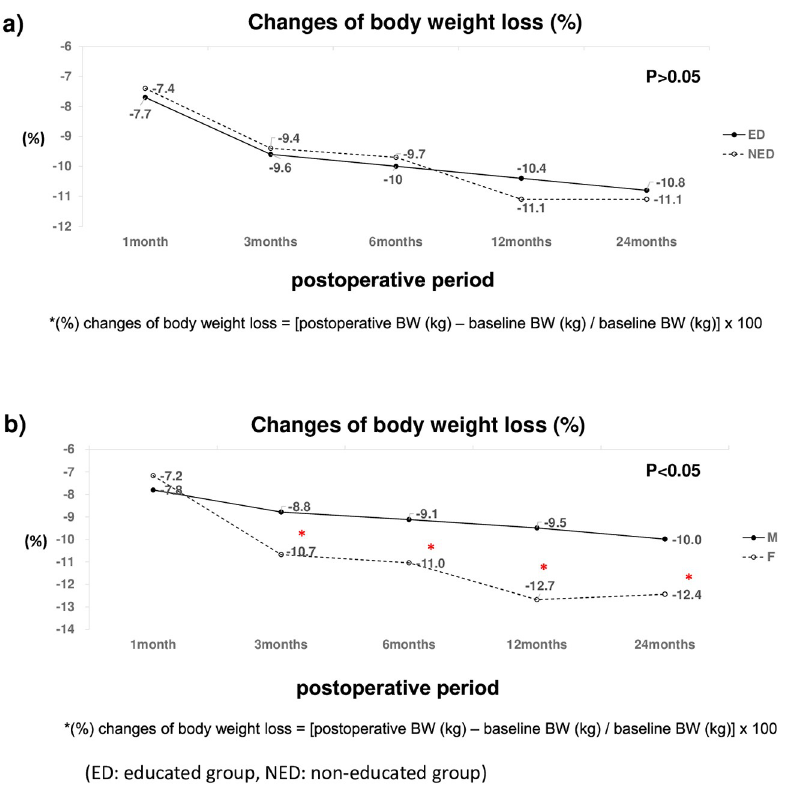
Fig 2. Changes in body weight loss (%) according to dietary education (a) and Gender (b). ED: Educated group; NED: Non-educated group.